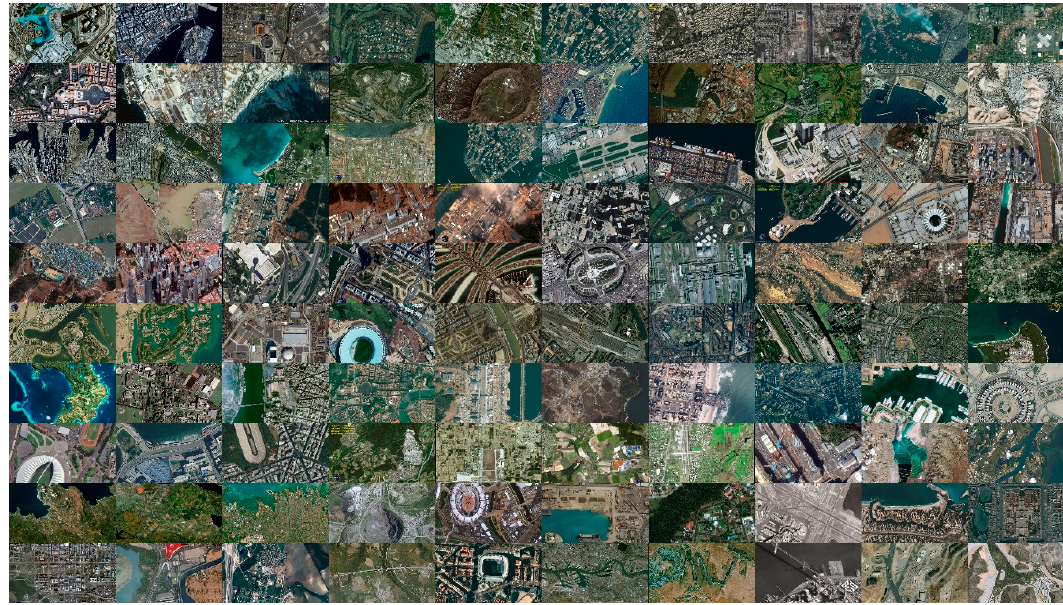
Figure 19. A set of 100 remote sensing images taken from [56] for experiments.